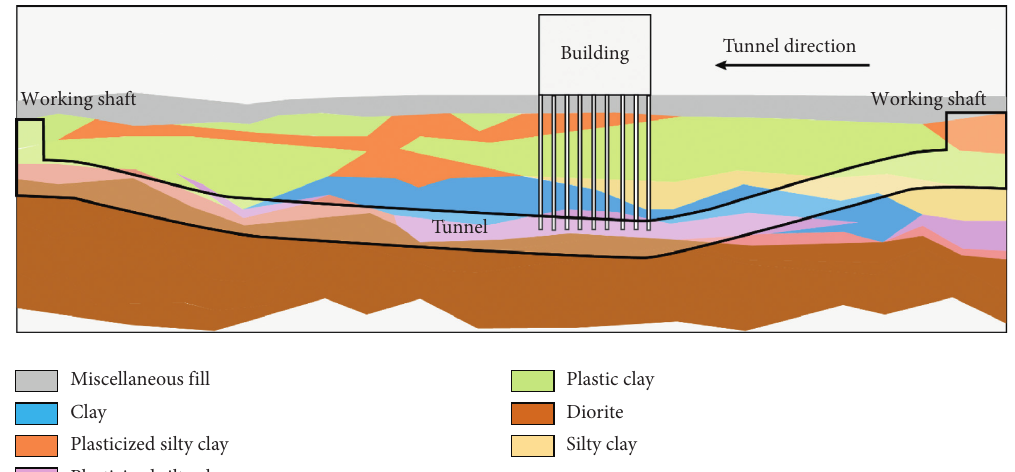
Figure 10: Geological profile of shield tunneling